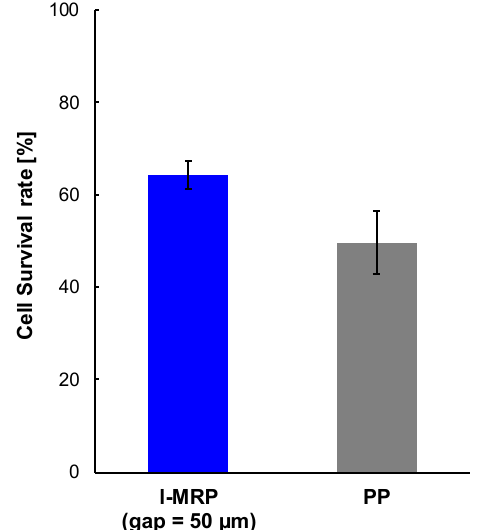
Figure 8. Survival rate of cells which were sent with the l-MRP (gap = 50 µ m) and the PP. The survival rates were 64% ± 6% (l-MRP) and 50% ± 7% (PP). The experiment was carried out one time for each pump.